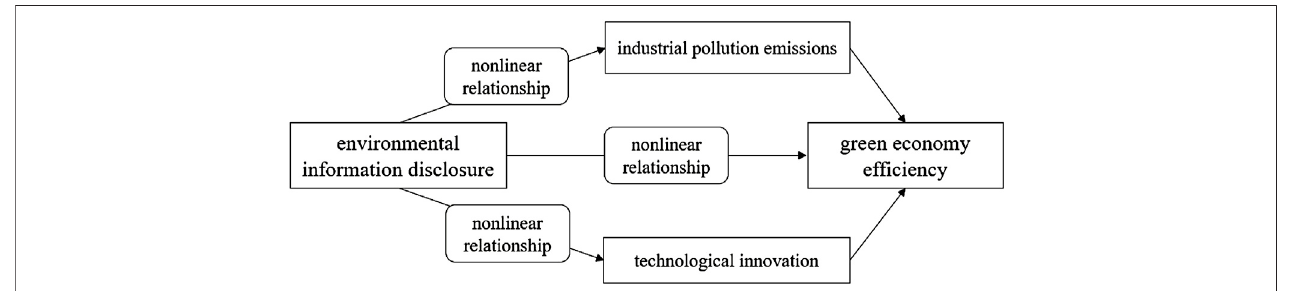
FIGURE 1 | Pathway of EID to